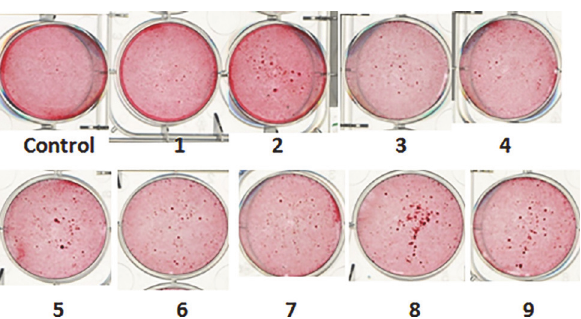
Fig 3. Effect of the nine compounds on the mineralization of UMR 106 cells using Alizarin Red S staining for demonstrating calcium nodules.